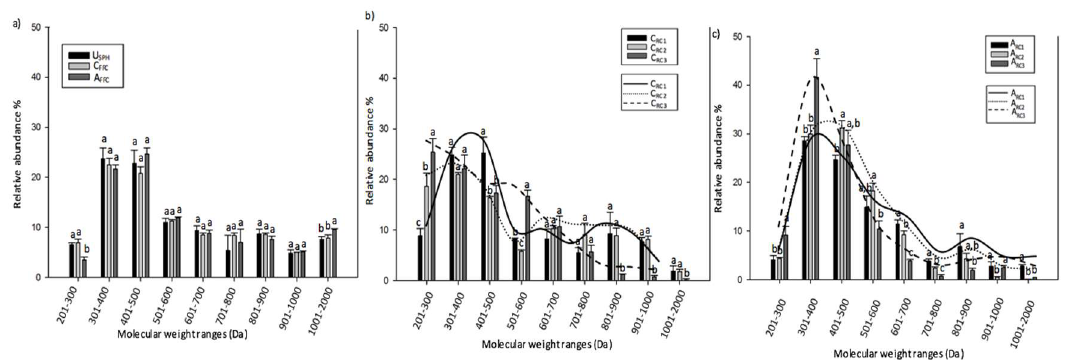
Figure 2. Profiles of peptide molecular weight in ( a ) U SPH , C FFC , and A FFC , ( b ) cationic compartments (C RC1 , C RC2 , and C RC3 ) and ( c ) anionic compartment (A RC1 , A RC2 , and A RC3 ) generated after 6 h of the EDUF process. Means with di ff erent lowercase letters within a molecular weight range are significantly di ff erent ( p < 0.05).